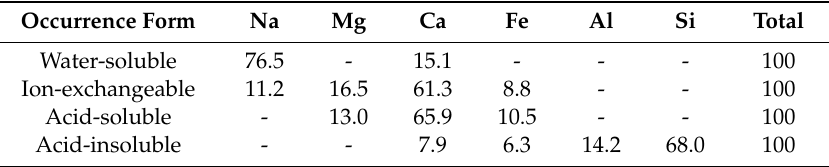
Significant level: the mass fraction was higher than